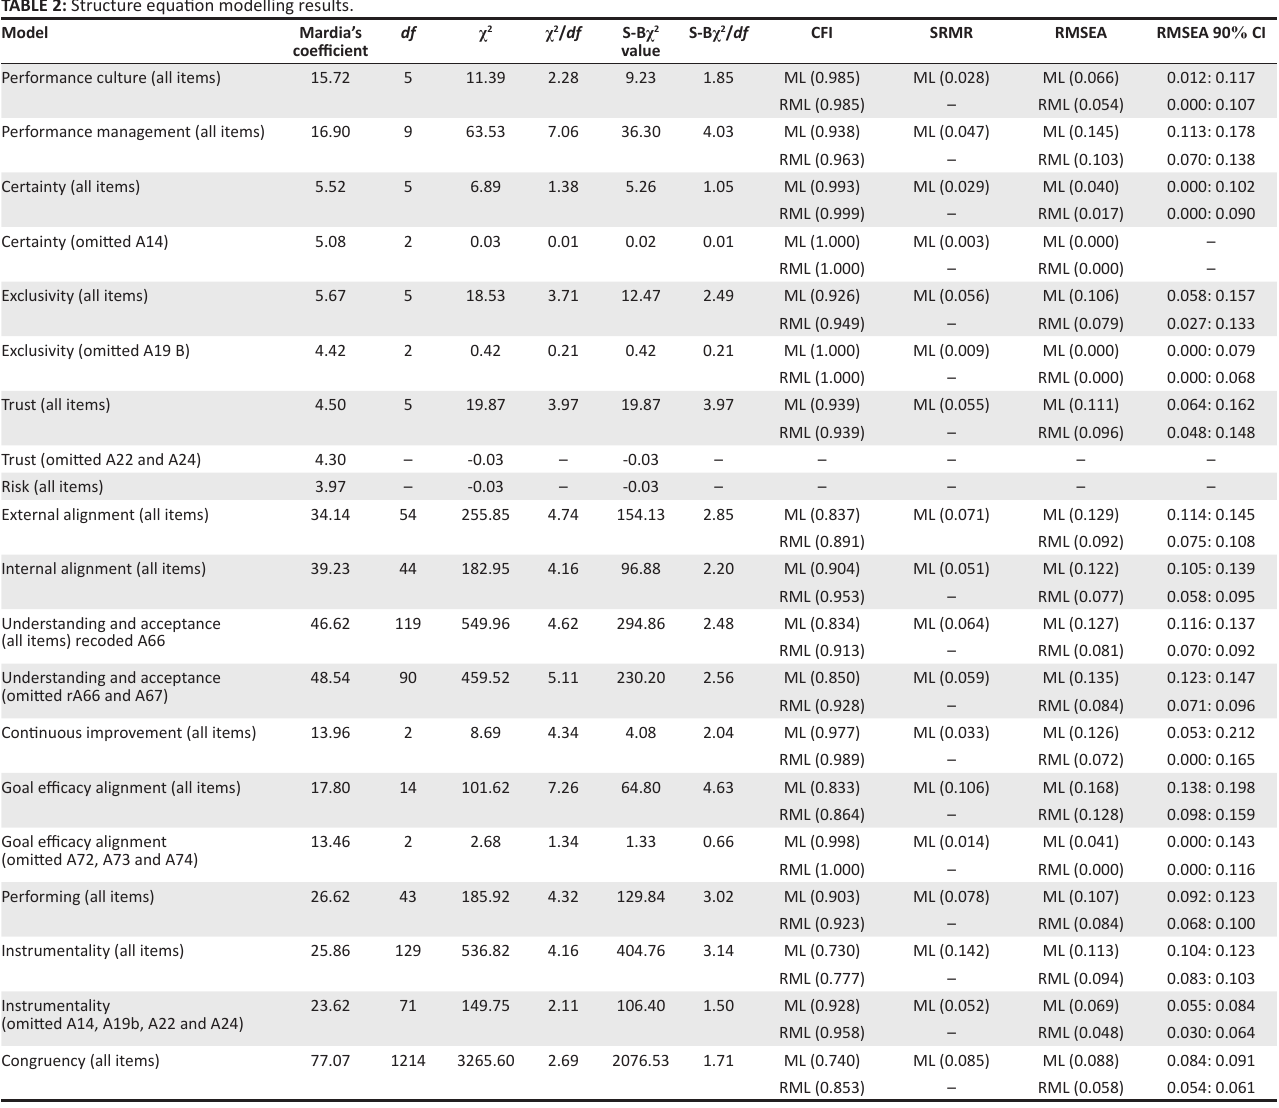
TABLE 2: Structure equation modelling